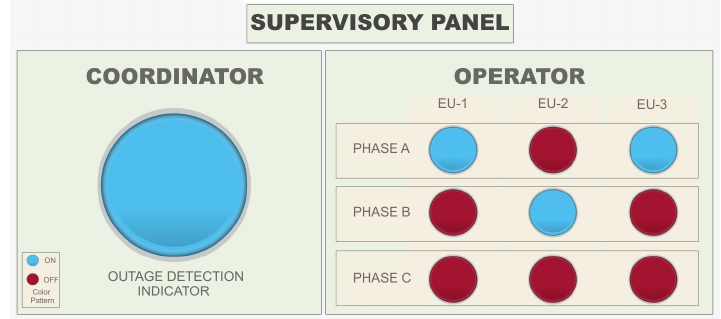
Figure 14. Presentation screen of the data concerning the result of the execution of the assay procedures (test algorithm) of Telemetry functionality.